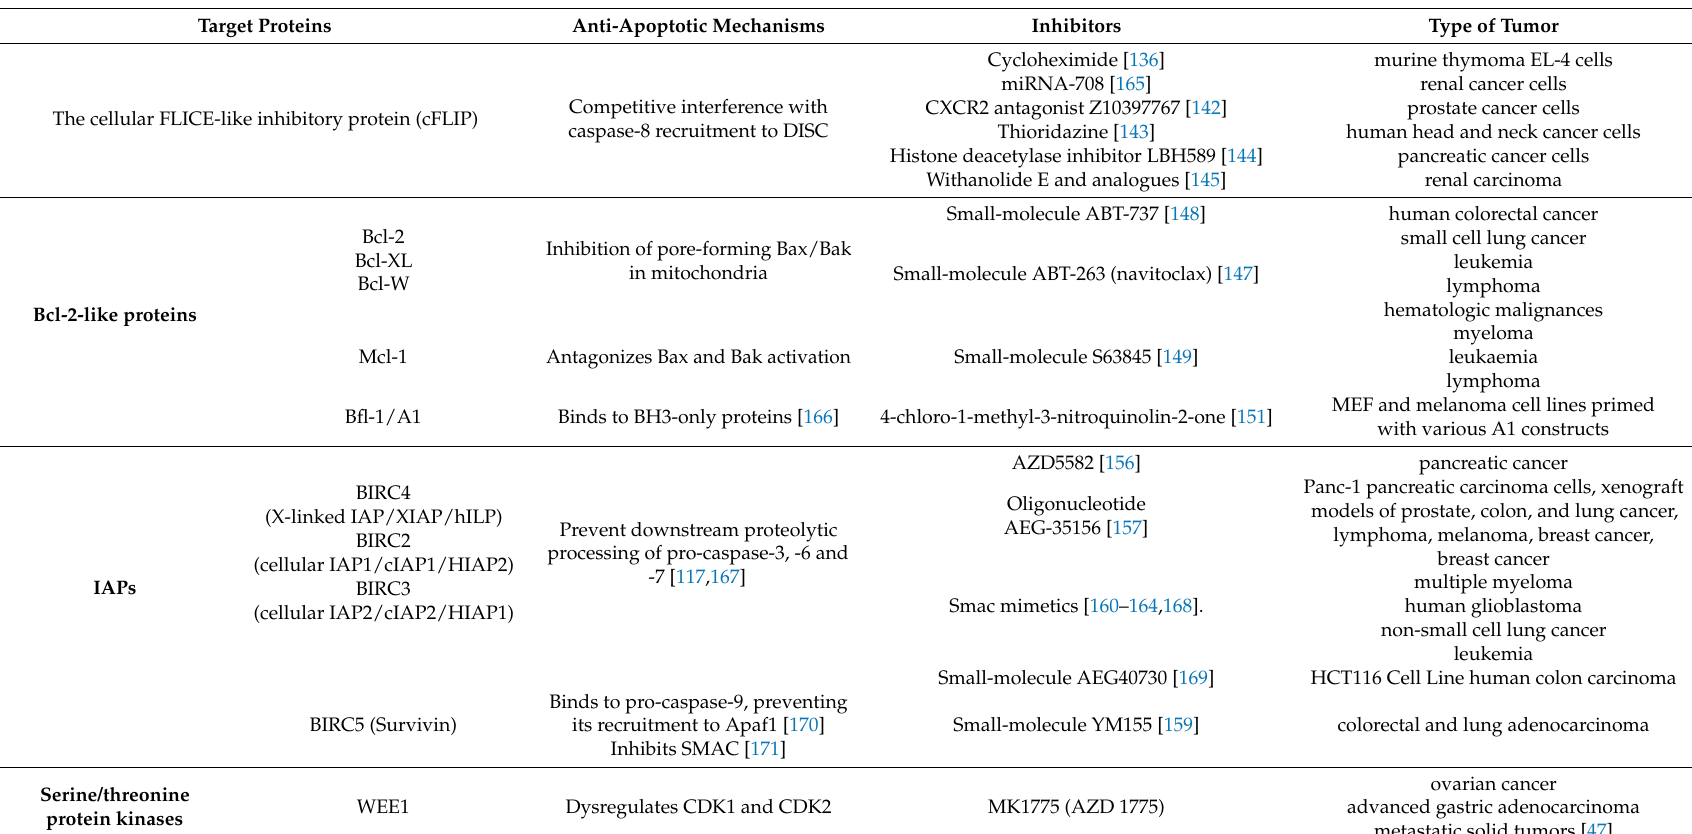
Table 1. Cellular targets for the inhibition of anti-apoptotic mechanisms in